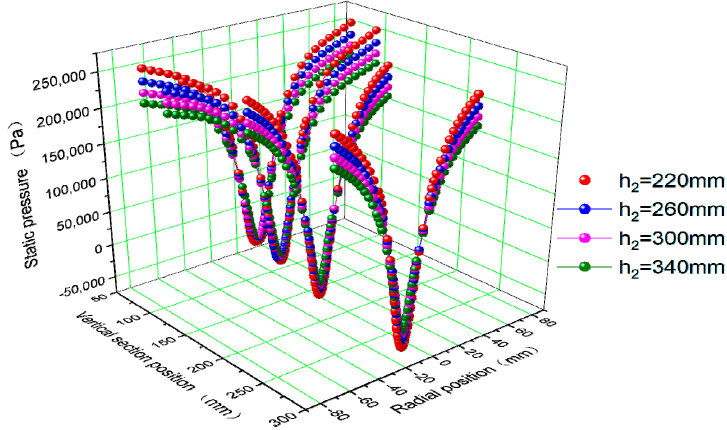
Figure 7. Distribution curve of static pressure.